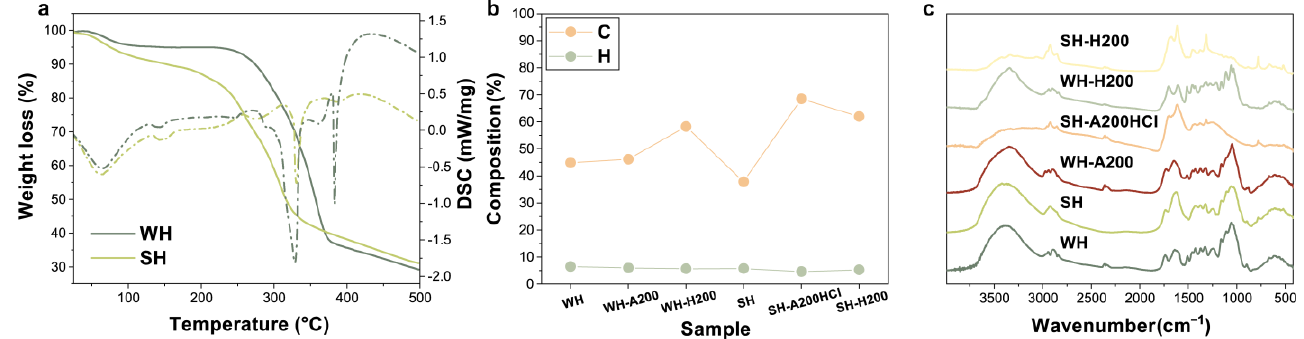
Figure 2. TG and DSC curves of WH and SH: ( a ) the results of elemental analysis (C and O in weight percent, %); ( b ) and FTIR spectra; ( c ) of winter hogweed (WH), summer hogweed (SH) and intermediate products after pretreatment.